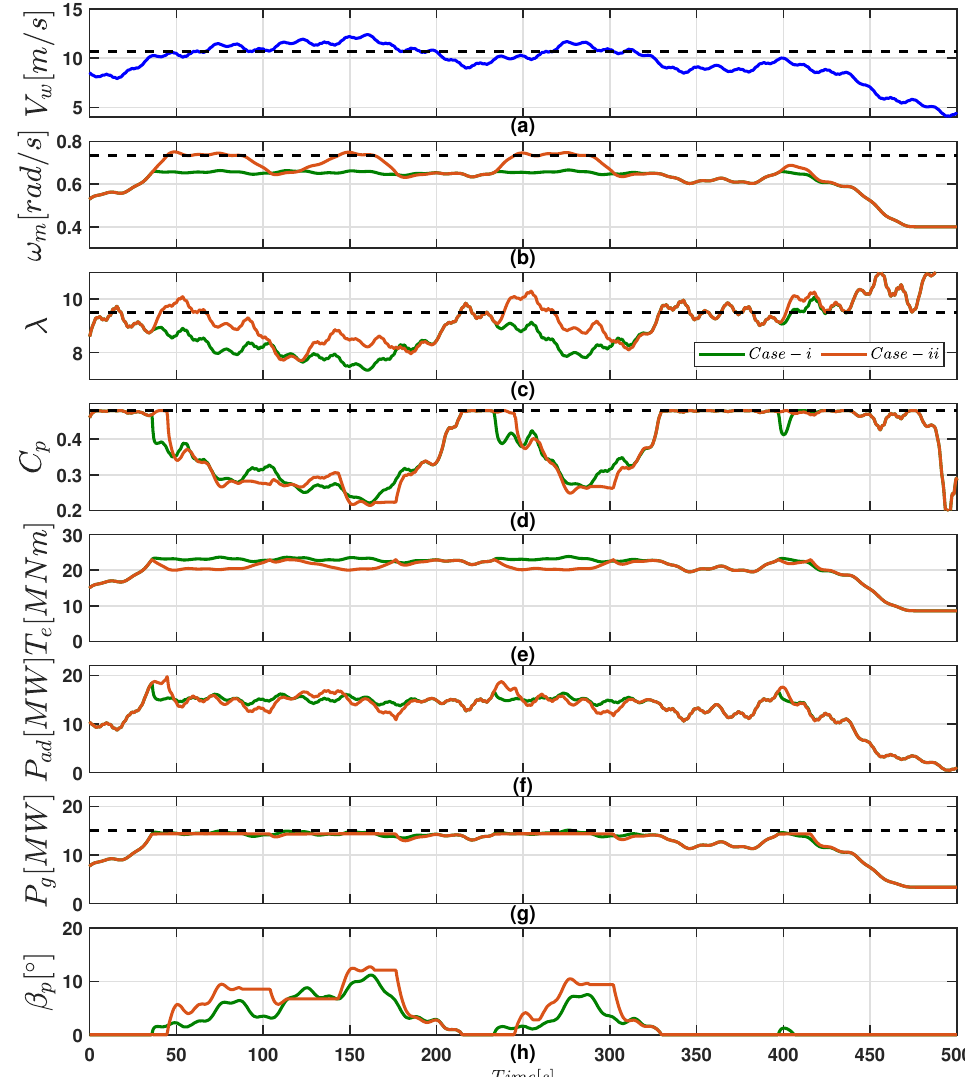
Figure 21. Comparative results to validate the active power control for reference